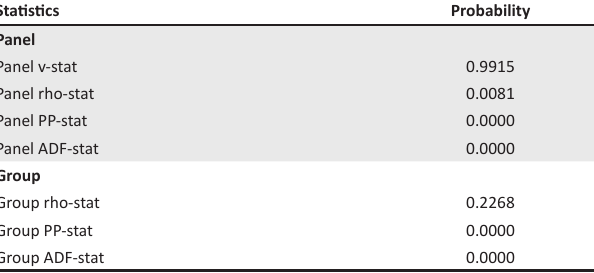
TABLE 3c: Pedroni panel cointegration test results (GDP BCG LLG BDG). Statistics